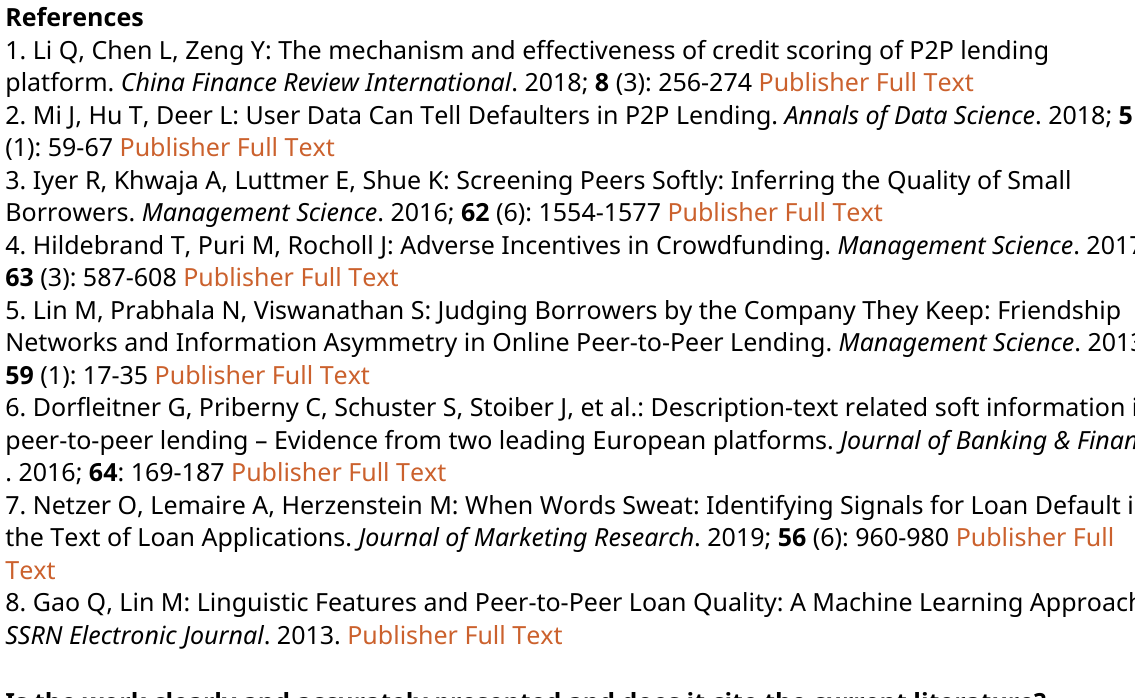
Figure 3. Interest rates and loan durations: The same concerns apply. Differences in interest rates applied to loans with similar maturities may be driven by other factors. Without controlling for all factors that matter for one’s credit risk, the authors should not draw a causal inference. For instance, the authors claim based on a univariate comparison that “the insignificant relationship between loan terms and interest rates suggests that a loan with a longer duration is not necessarily viewed as having a higher probability of default at the nine Malaysian P2P lending platforms. Therefore, it should not be charged with a higher interest rate than one with a shorter duration.” This statement is simply not true if the loan with a shorter maturity is given to a firm that is inherently riskier in other aspects compared to the firm that is getting a loan with a longer maturity. The positive relationship between loan maturity and risk may still be there if all the other risk factors are controlled for. Figure 5: the same comments apply. ○ Study limitation: all the analyses are driven by univariate comparisons. This is a correlation study, thus causal interpretations should be interpreted with